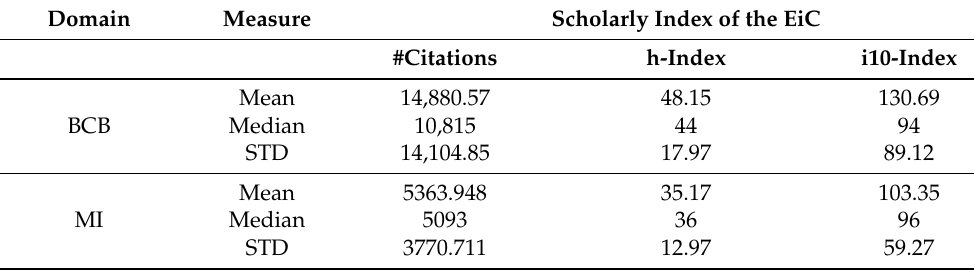
Table 2. Various statistics of the scholarly metrics of EiCs of top BCB and MI